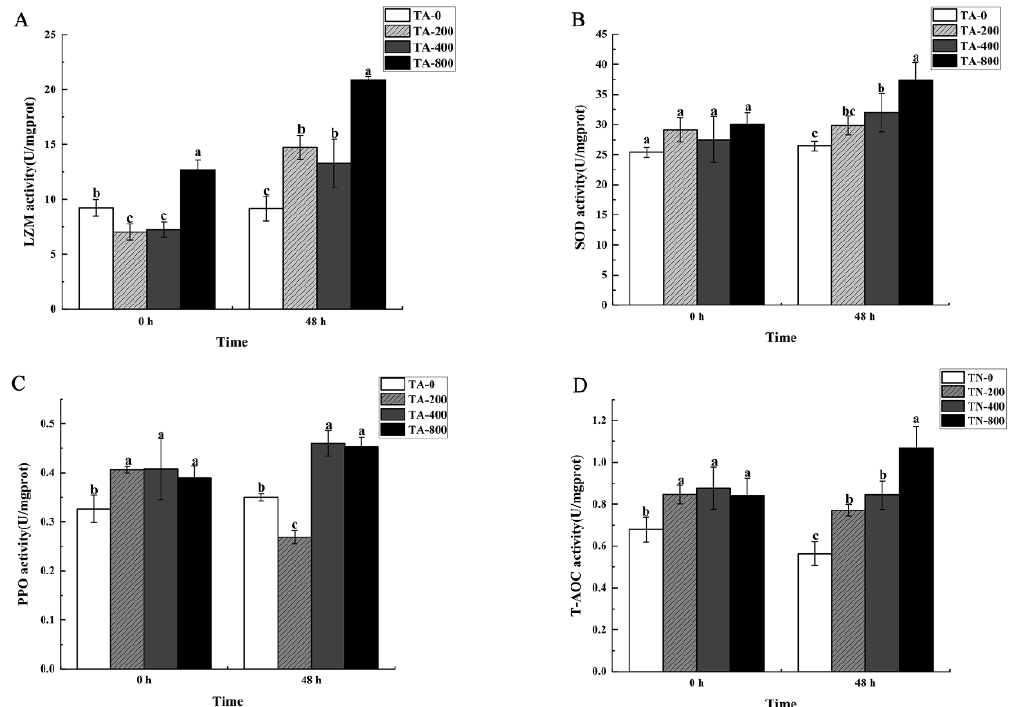
Figure 5. Immune enzymes activity in the hepatopancreas of L. vannamei that were fed the control and TA diets for 56 days (0 h) before being exposed to ammonia stress for 48 h. ( A ) LZM activity; ( B ) SOD activity; ( C ) PPO activity; ( D ) T-AOC activity. Vertical bars represented the mean values ± SD ( n = 3). Data marked with different letters were significantly different ( p < 0.05) among groups.